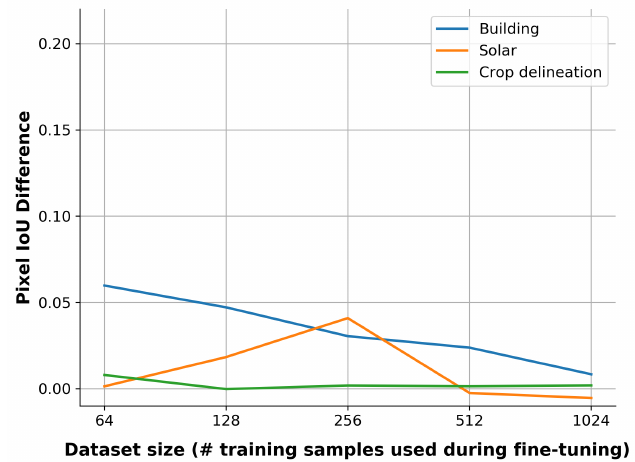
Figure 4. Pixel IoU increase resulting from further pre-training on the target dataset over the supervised ImageNet encoder.